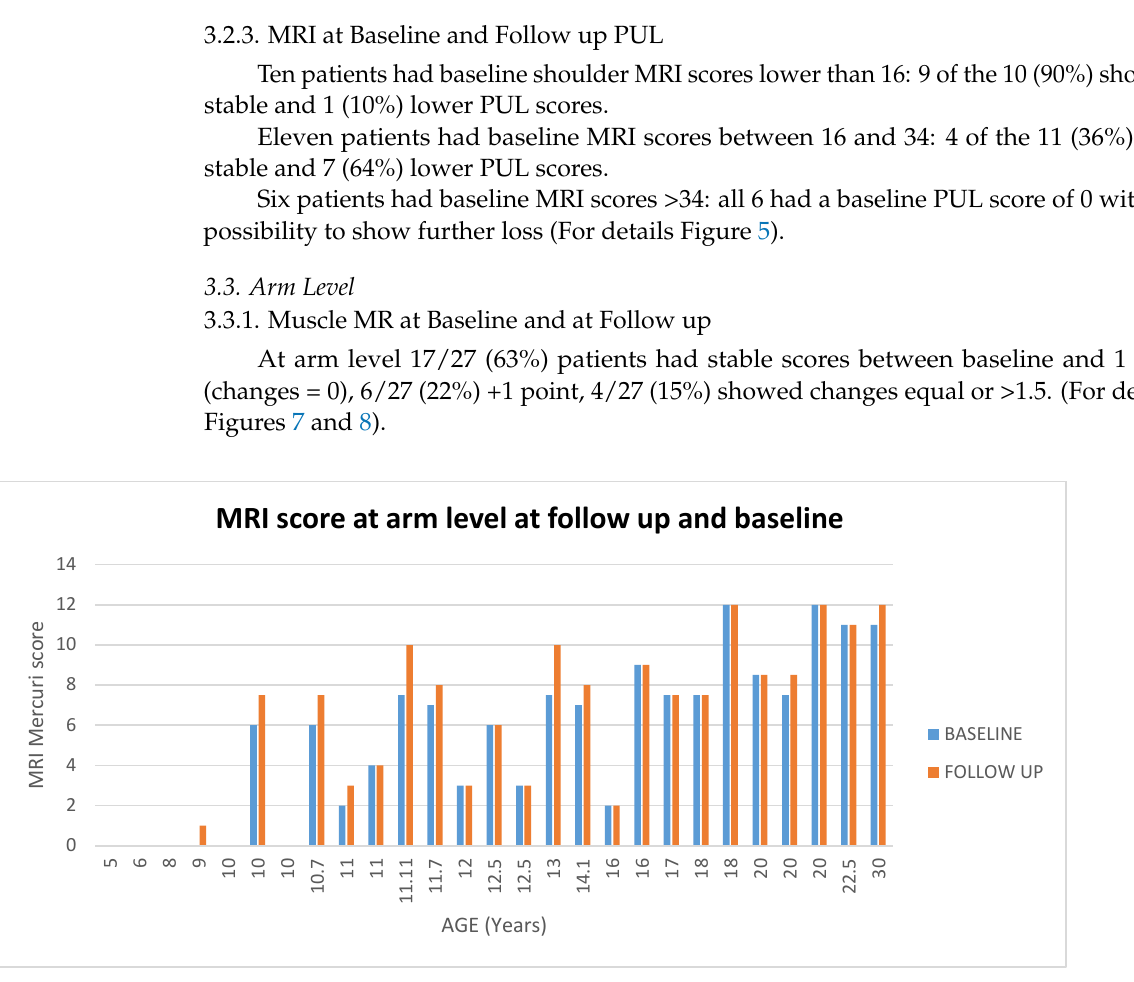
Figure 7. showed scores in muscle MRI at arm level at baseline and at follow up according to age.